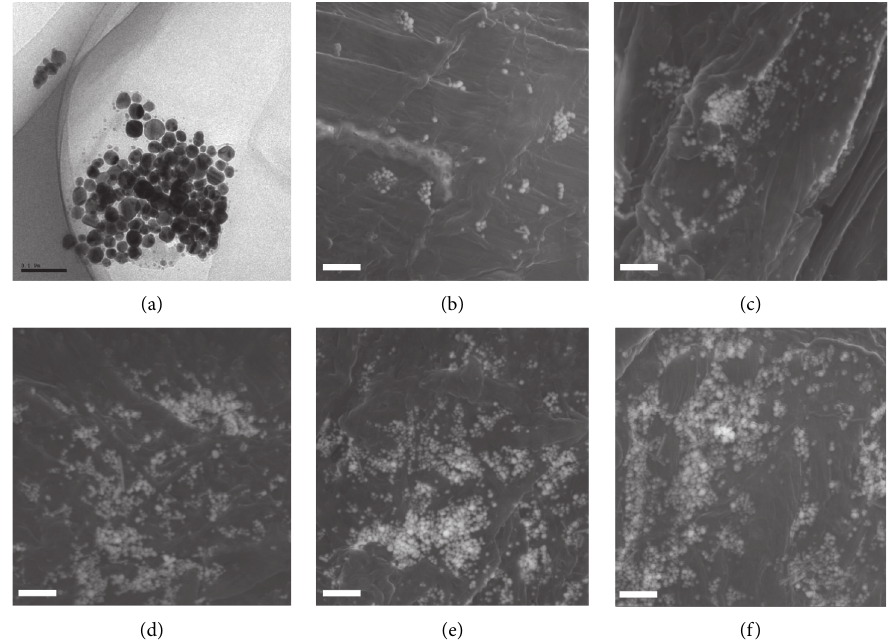
Figure 2: (a) The TEM image of AgNPs and the SEM images of test strips surface after (b) 1 cycle, (c) 2 cycles, (d) 3 cycles, (e) 4 cycles, and (f) 5 cycles of dip-coating and heating. The scale bar of the TEM image is 0.1 μ m, and the scale bar of the SEM images is 0.5 μ